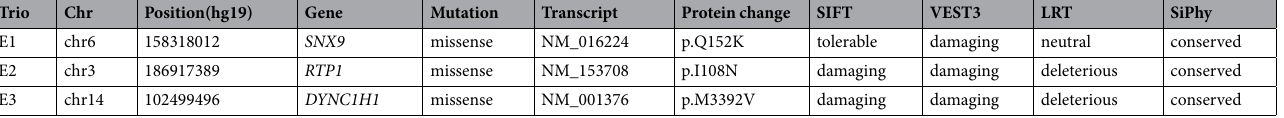
Table 1. Summary of DNMs detected by trios-based WES of